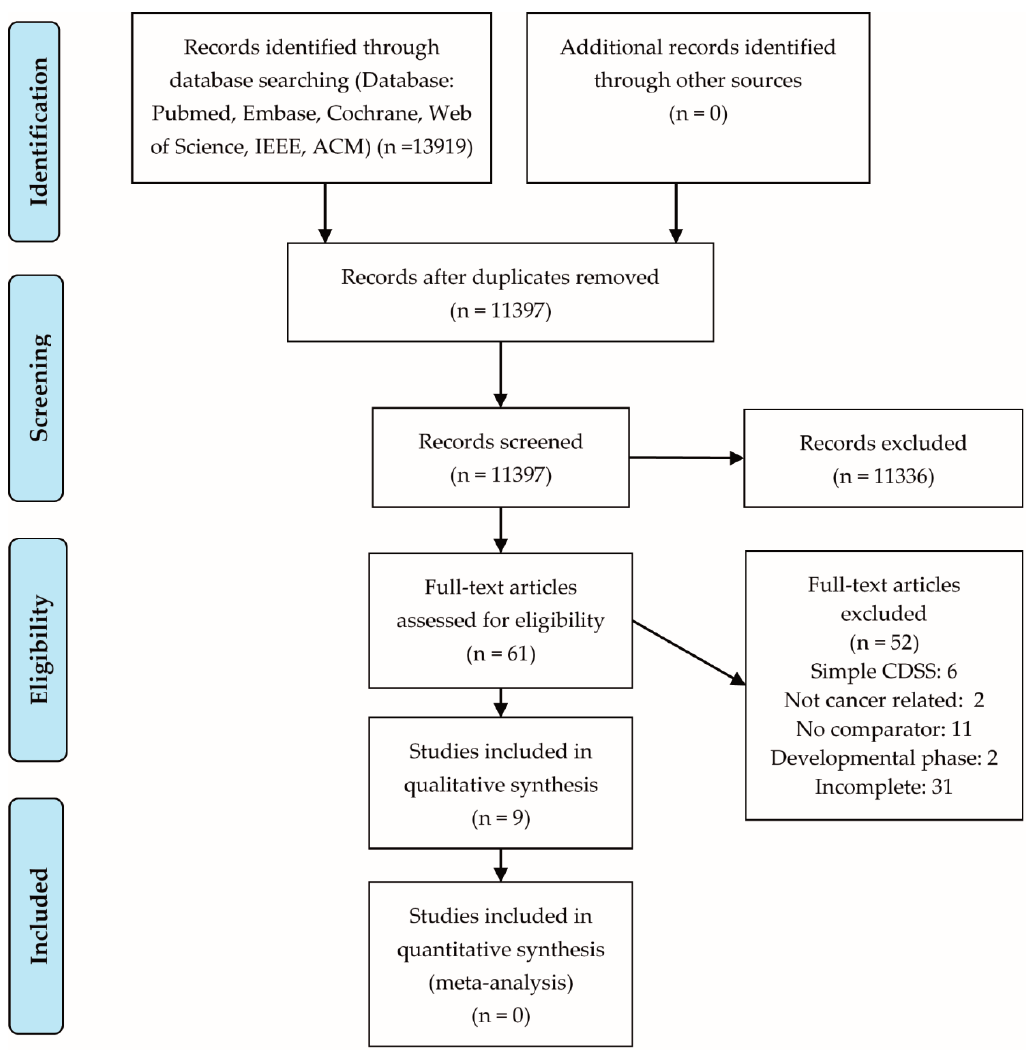
Figure 1. PRISMA-P 2015 flowchart.